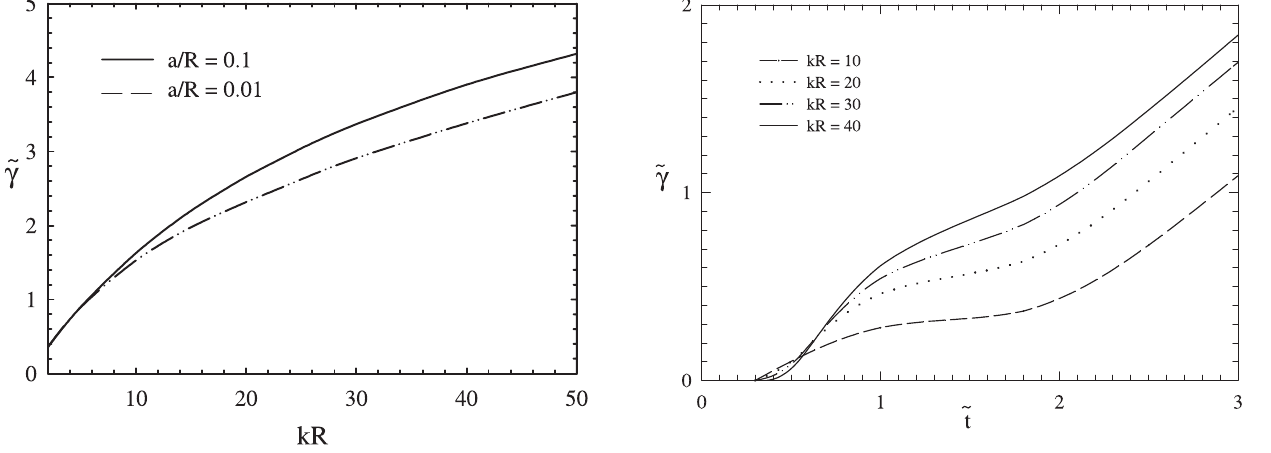
Fig. 6. Normalized instability growth rate as a function of time for the nonsteady magnetosheath profiles corresponding to different wave numbers kR = 10; 20; 30;